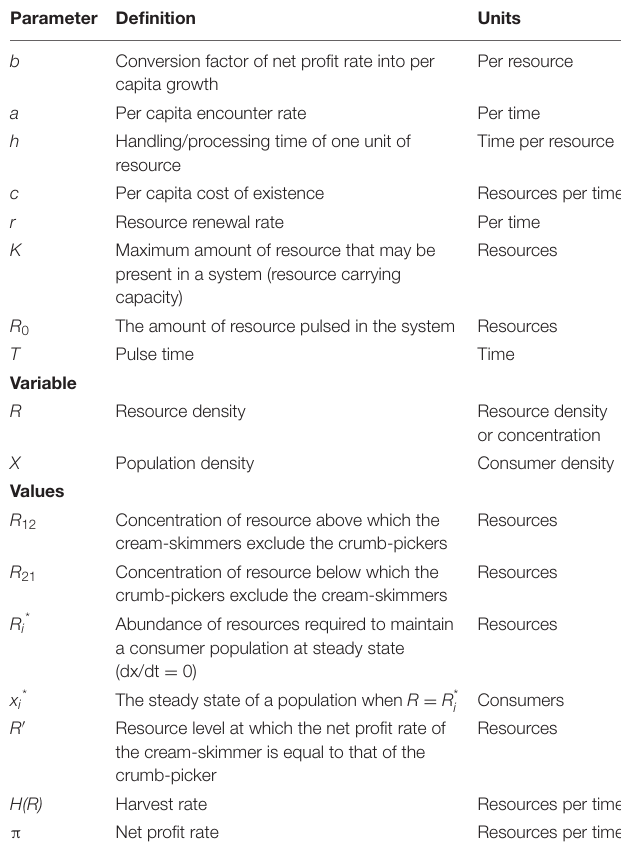
TABLE 1 | Model parameters, variables, and critical